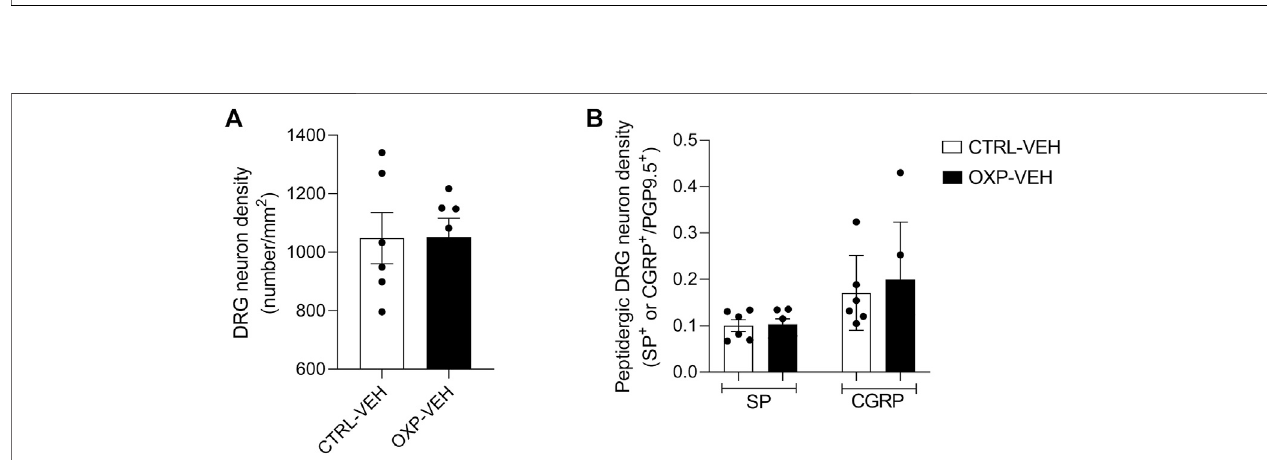
FIGURE 3 | Effect of OXP on dorsal root ganglion neurons. DRG of CTRL-VEH and OXP-VEH mice were immunostained with PGP9.5 and substance P (SP) or calcitonin-gene related peptide (CGRP). (A) Quanti fi cation of PGP9.5 + total DRG neuron density. (B) The density of peptidergic neurons is expressed as SP + or CGRP + neurons/PGP9.5 + neurons. OXP-treated mice received OXP at a cumulative dose of 15 mg/kg (5 mg/kg/3 days, intraperitoneal). CTRL: control, DRG: dorsal root ganglion, PGP9.5: protein gene product 9.5, OXP: oxaliplatin, VEH: vehicle.